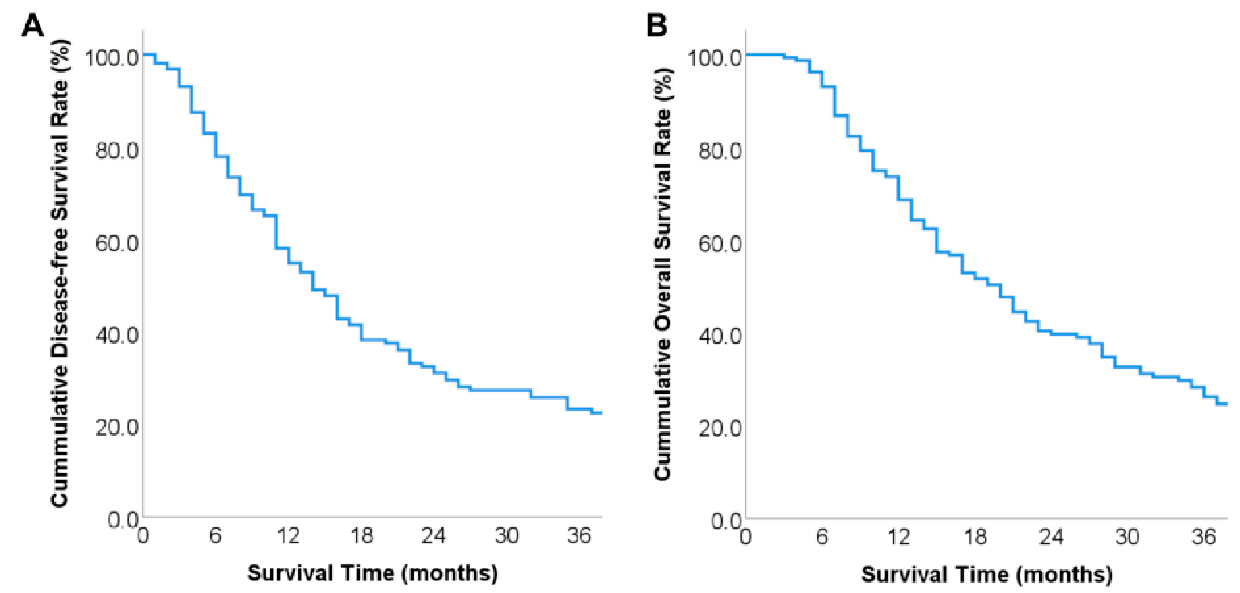
Figure 2. Long-term prognosis of patients: ( A ) overall disease-free survival curve of included patients; ( B ) overall survival curve of included patients.